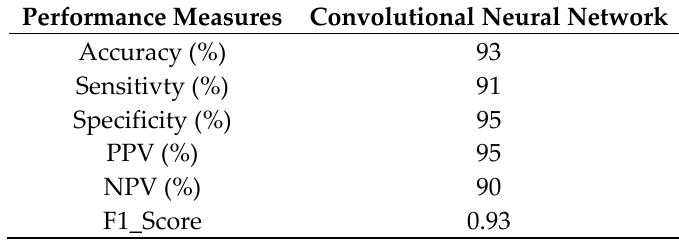
Table 1. Performance Measures of Convolutional Neural Network